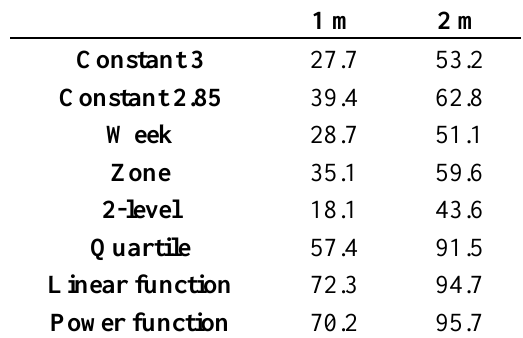
Table 3. The results of the applicability testing with the independent dataset of 2011. The relative shares (%) of the modeled Z values deviating maximum of 1 m or 2 m from the eu observed Z values, n = eu